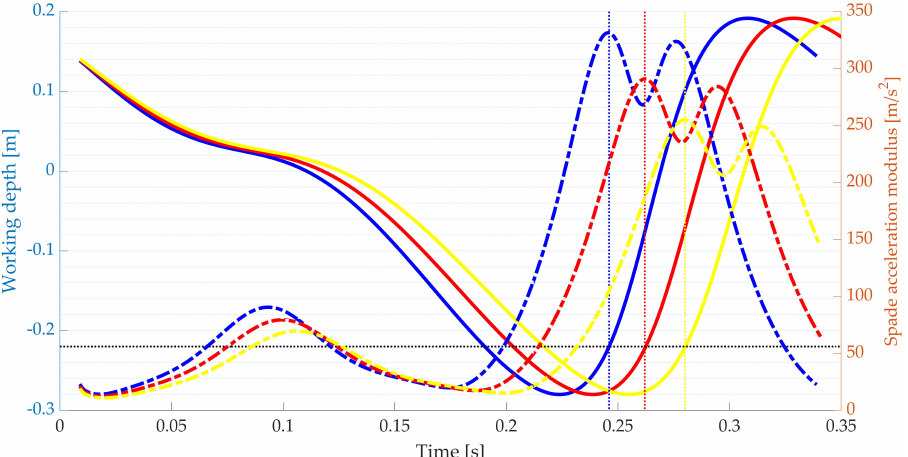
Figure 16. Comparison of the acceleration modulus and the variation of the spade-tip vertical displacement for the working cases I, V, and IX (first cycle presented).